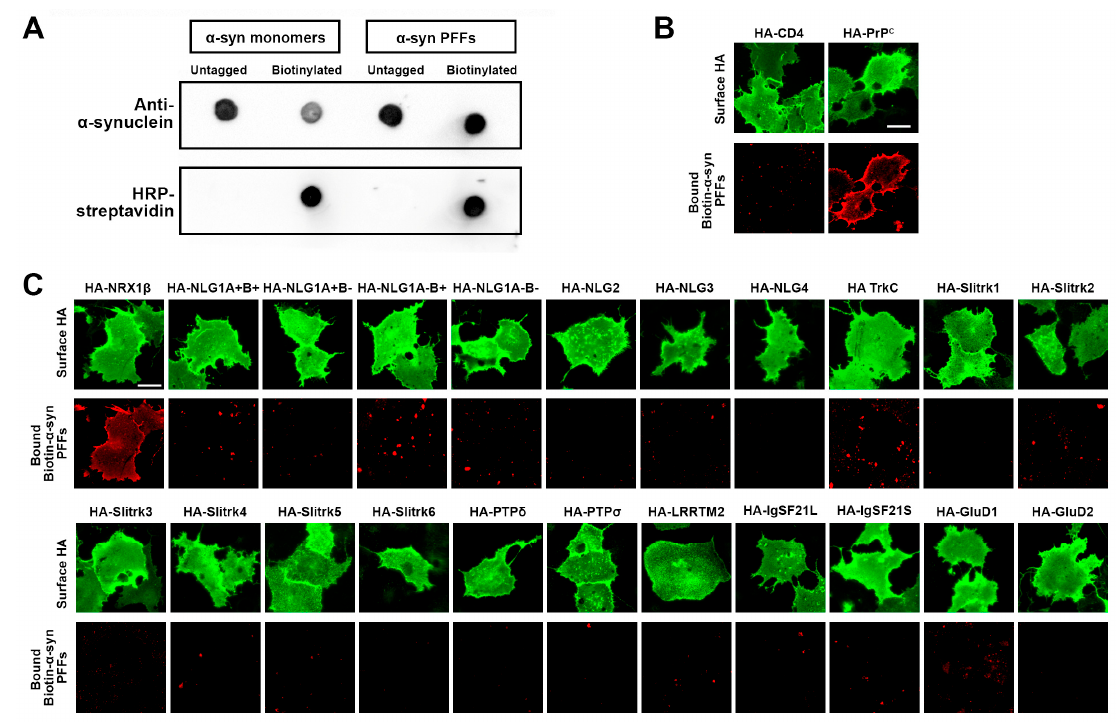
Figure 2. A candidate screen based on cell surface protein binding assays using biotin-conjugated α -syn PFFs isolates neurexin1 β (NRX1 β ) as an α -syn PFF-interacting protein. ( A ) Validation of biotin conjugation to α -syn monomers and PFFs by dot blot assays. Untagged and biotin-conjugated α -syn monomers and PFFs were spotted onto a nitrocellulose membrane and immunolabeled with anti- α -synuclein antibody to confirm the presence of the indicated proteins. After stripping the anti- α -synuclein antibody, the membrane was labelled with HRP-conjugated streptavidin to detect biotin-conjugated proteins. Only biotin- α -syn monomers and PFFs, but not untagged ones, display HRP-streptavidin-based signals. ( B ) A cell surface protein binding assay shows that the biotin- α -syn PFFs bind to COS-7 cells expressing the N-terminal extracellular HA-tagged cellular prion protein (HA-PrP c ), which is a known α -syn PFF-interacting protein, but not those expressing HA-CD4 as a negative control. The surface HA was immunolabelled to verify the expression of these constructs on the COS-7 cell surface. Scale bar: 30 µ m. ( C ) Representative images showing cell surface protein binding assays testing for interaction between α -syn PFFs (1 µ M, monomer equivalent) and known synaptic organizers. COS-7 cells expressing the indicated construct were exposed to α -syn PFFs. α -syn PFFs bind to COS-7 cells expressing HA-tagged neurexin 1 β (HA-NRX1 β ), but not to